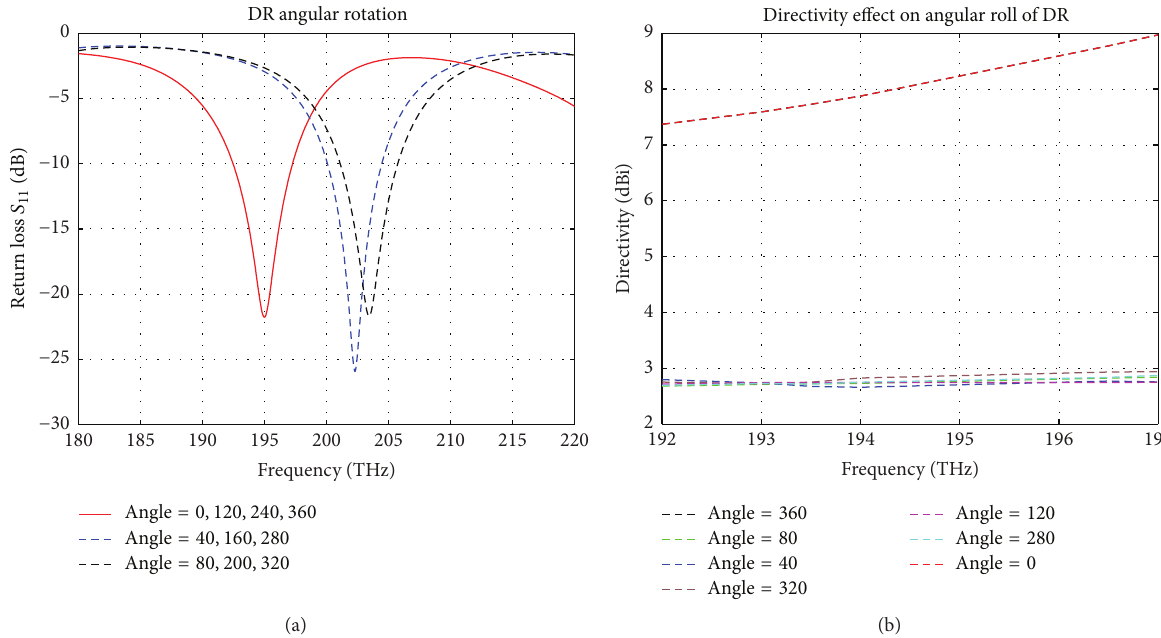
Figure 7: (a) Angular rotation effect on resonant frequency. (b) DR’s angular rotation effect on directivity.